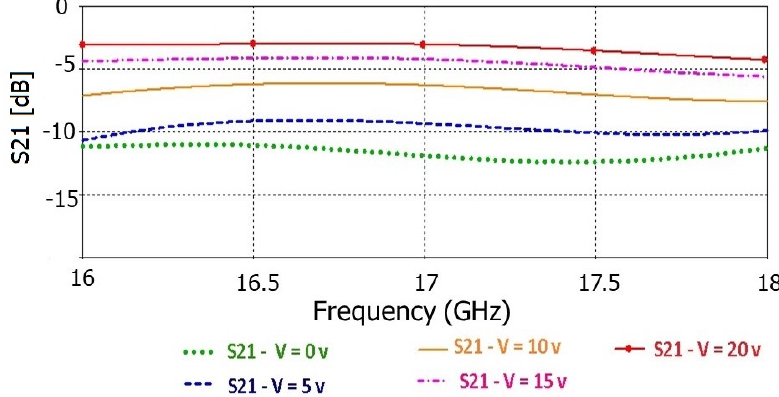
Figure 7. Phase variation of the SIW variable phase shifter for five different biasing voltages.